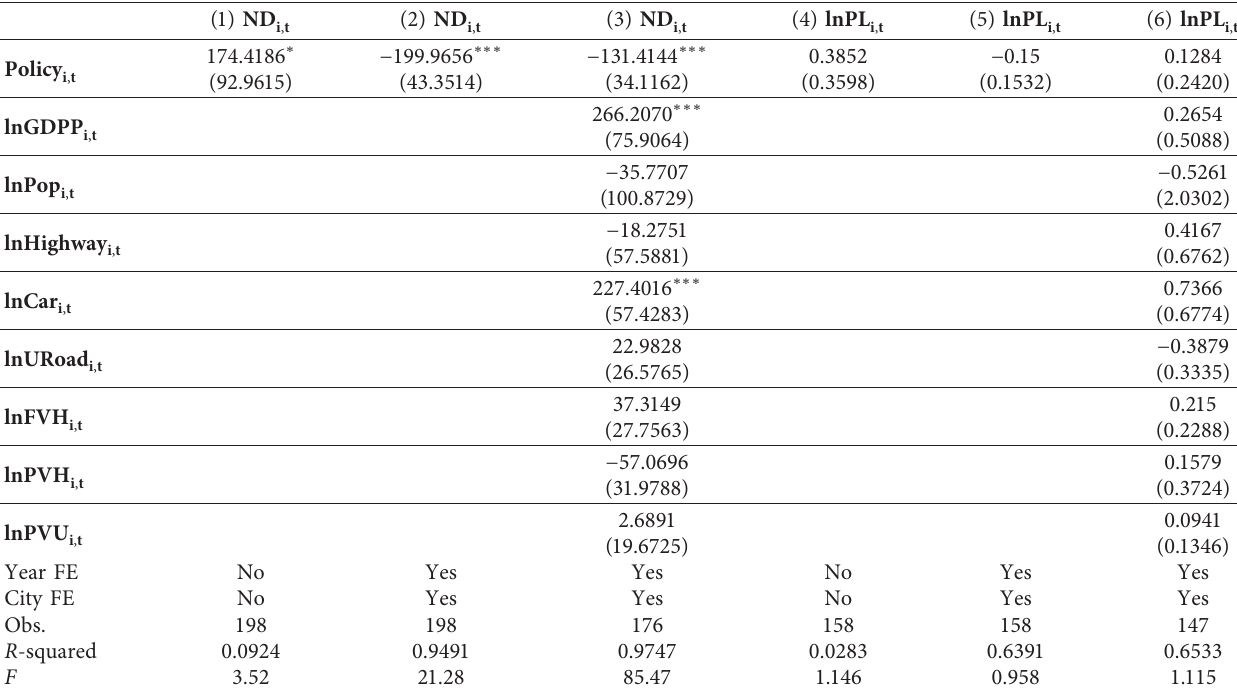
Table 5: The effect of the motorcycle bans on traffic accidents.